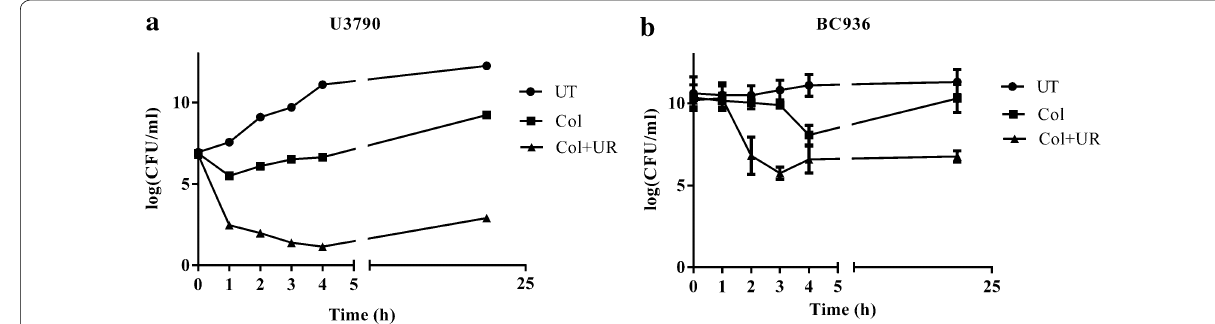
Fig. 1 Time kill curve: UR potentiates the effect of colistin and causes growth reversal in resistant isolates of a E. coli U3790, b K. pneumoniae BC936. The culture was treated with colistin (Col—filled square) alone and colistin with ursolic acid (filled triangle). The samples were withdrawn at time intervals from 0, 1, 2, 3, 4 and 24 h and plated on to LB agar plates. The error bar represents the standard error of mean of three independent samples